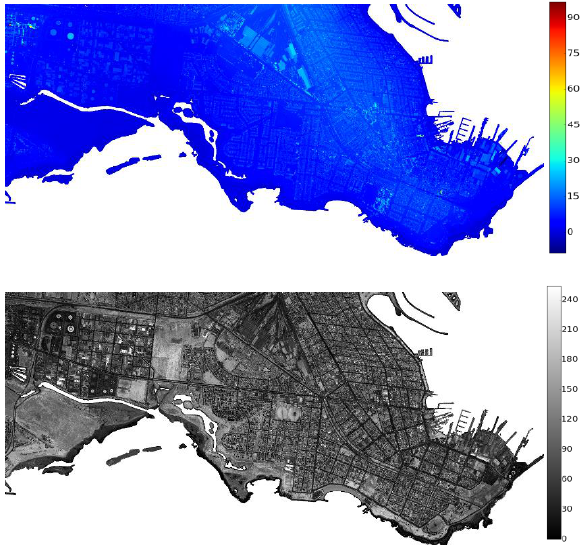
Figure 3. Colour-coded LiDAR DSM (top) and LiDAR intensity image (bottom).